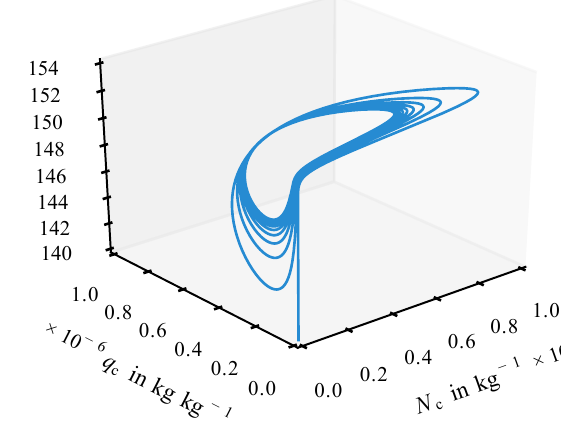
Figure 5. Stable focus for state 1 at T = 220K, w = 0 . 01ms − 1 : or- bit in phase space approaching the equilibrium state asymptotically.